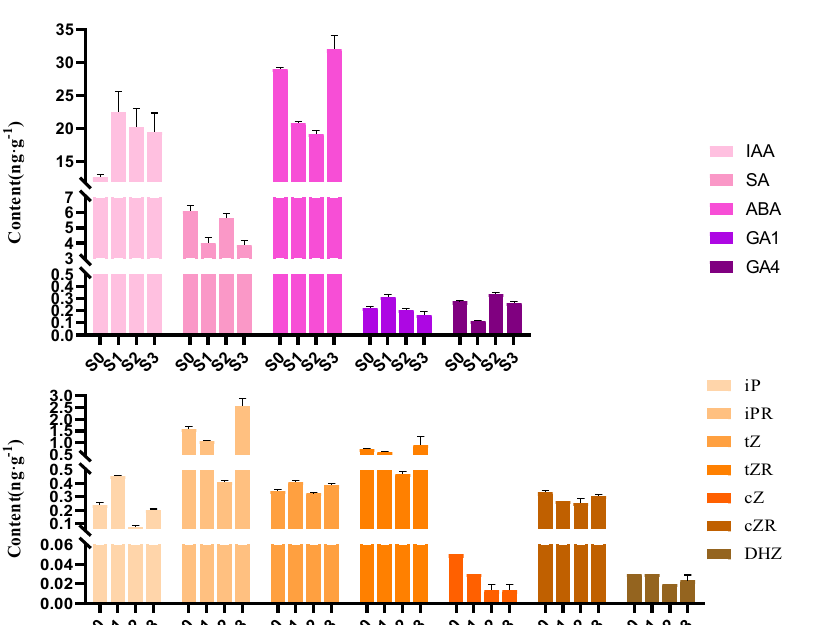
Figure 2. Contents of the 12 endogenous hormones in the four statuses of Phalaenopsis spike development. Error bars indicate the standard deviation (SD) of the mean ( n = 3). IAA (irindole-3-acetic acid), SA (salicylic acid), ABA (abscisic acid), GA1 (gibberellic acid 1), GA4 (gibberellic acid 4), iP (isopentenyl adenine), iPR (isopentenyl adenosine), tZ ( trans -zeatin), tZR ( trans -zeatin riboside), cZ ( cis -zeatin), cZR ( cis -zeatin riboside), and DHZ (dihydrozeatin).